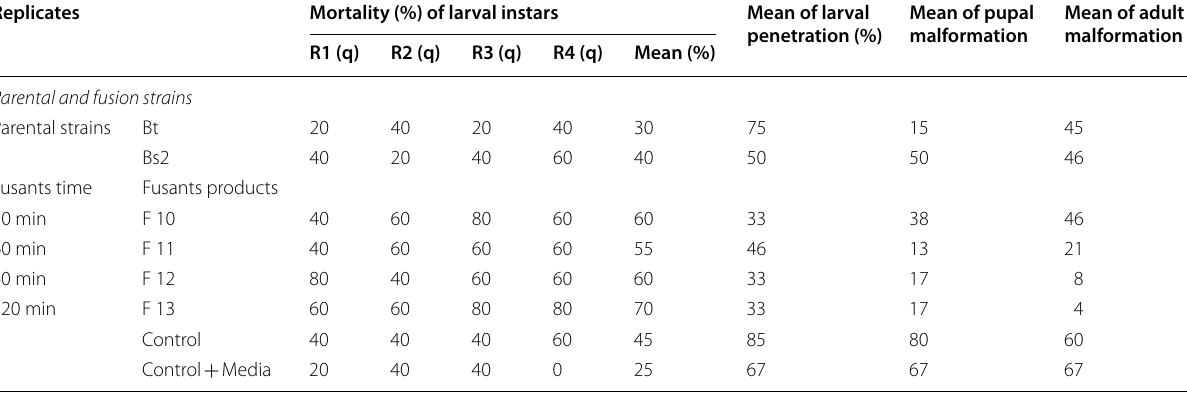
Table 5 Effect of different fusants of ( Bt::Bs2 ) on a biological feature of the Phthorimaea operculella